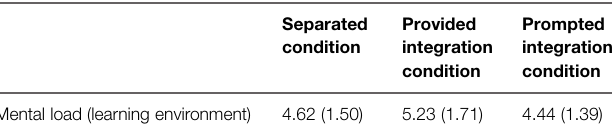
TABLE 5 | Mean (and SD) of mental load while working on the learning environment in the three experimental groups.